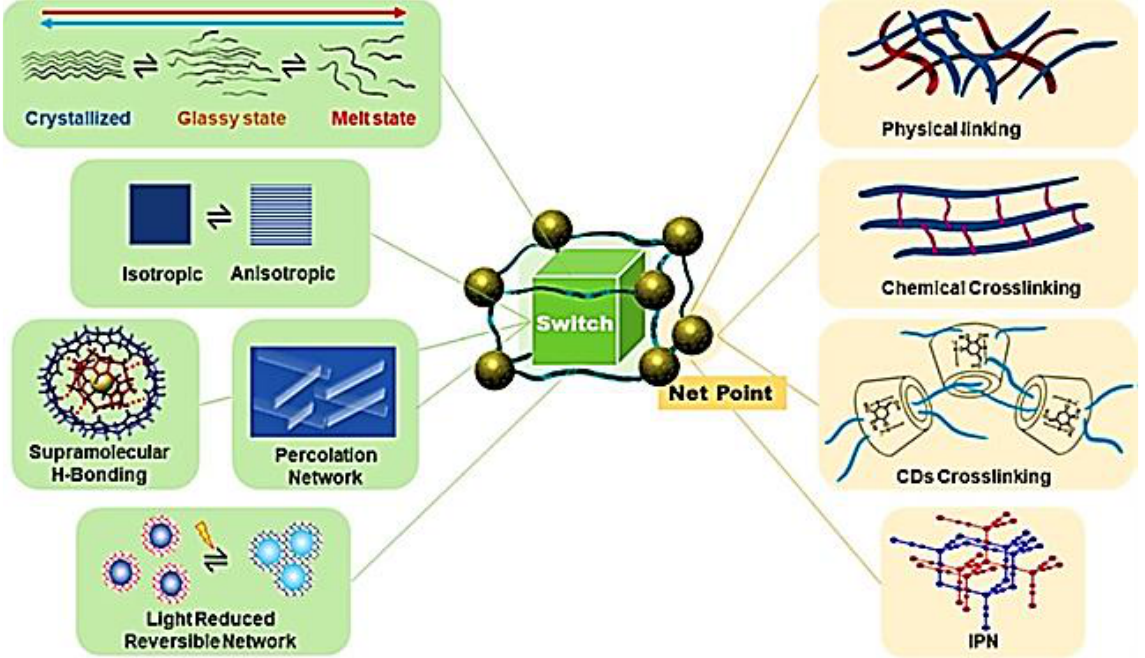
Figure 2. Schematic of comprehensive architecture of shape memory polymers [27]. Reproduced with permission from Springer.